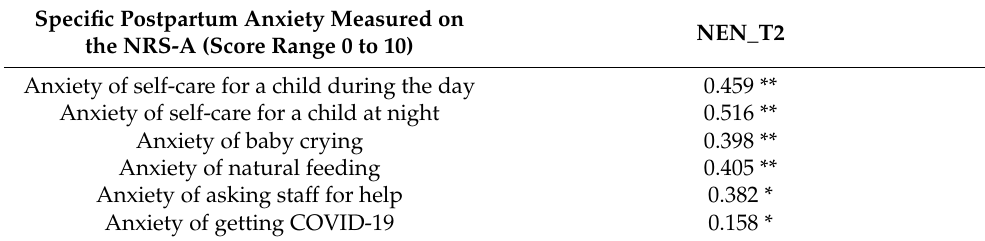
Table 4. Correlations between the need to entrust the newborn under the care of staff and the specific anxiety on the second day of